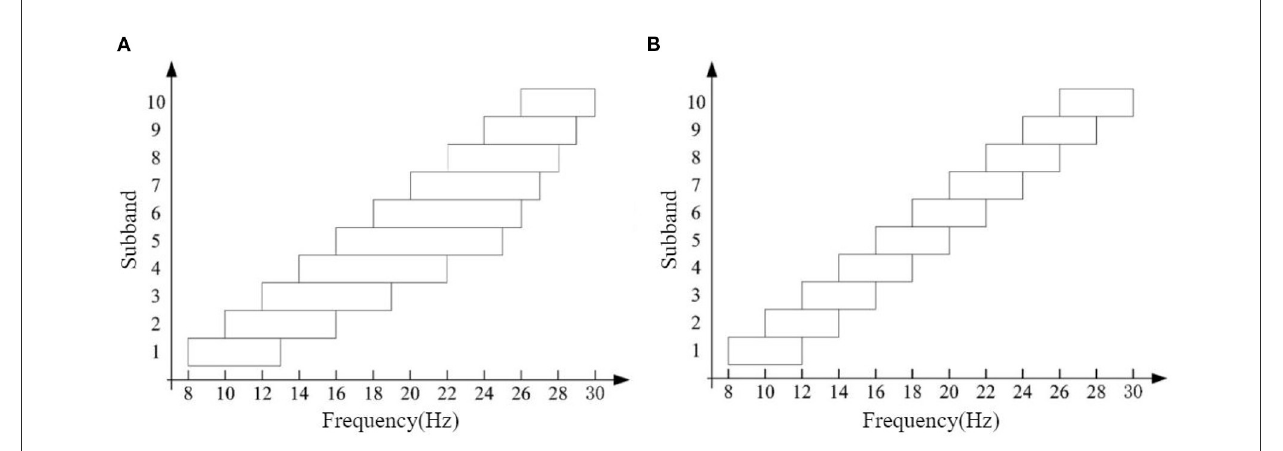
FIGURE4 Frequency band selection scheme: (A) VFB and (B)